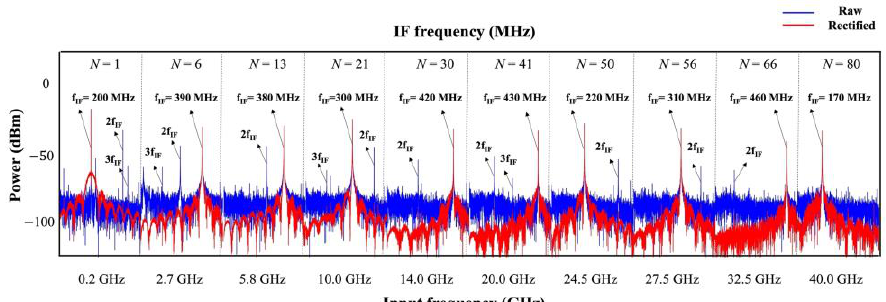
Figure 4. Effects of deep learning-based spurious elimination in the frequency domain with the input signal of various input power, ranging from 0 to 40 GHz. The selected displayed input frequencies are 0.2 GHz, 2.7 GHz, 5.8 GHz, 10.0 GHz, 14.0 GHz, 20.0 GHz, 24.5 GHz, 27.5 GHz, 32.5 GHz, and 40.0 GHz, which were all down-converted to the first Nyquist zone (0–515 MHz) with the frequencies of 200 MHz, 390 MHz, 380 MHz, 300 MHz, 420 MHz, 430 MHz, 220 MHz, 310 MHz, 460 MHz, and 170 MHz, respectively. N represents the Nyquist zone of each input signal.